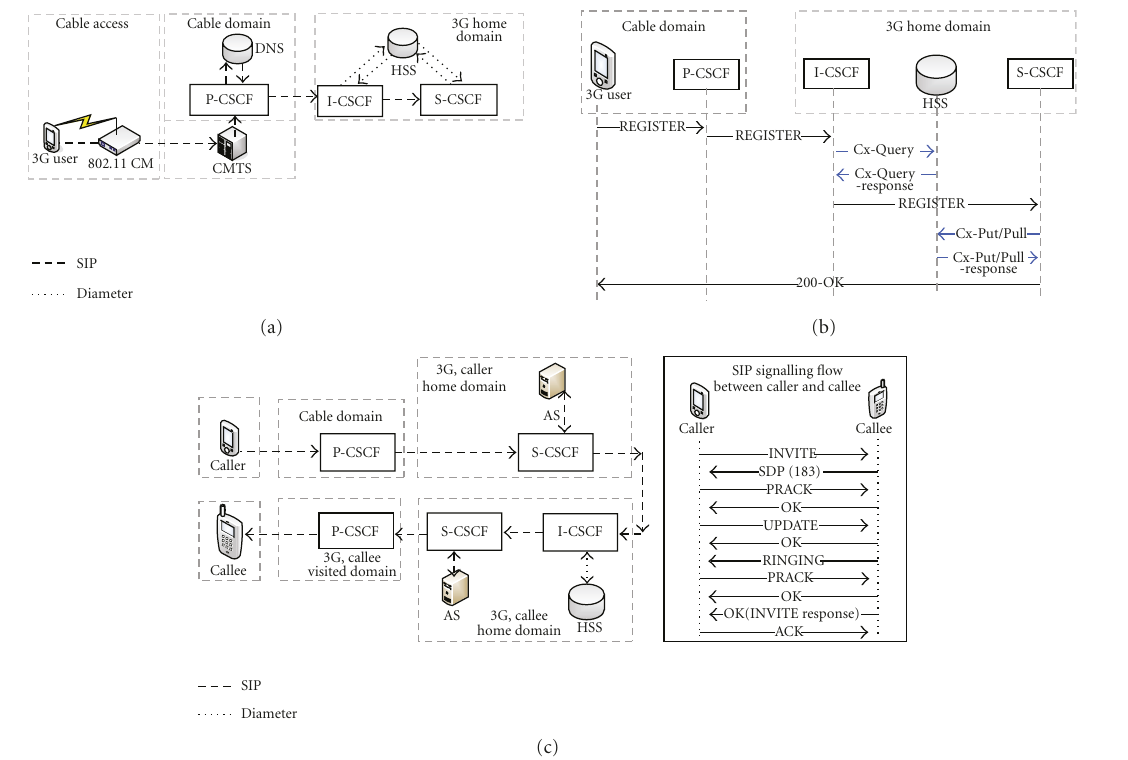
Figure 6: (a) Registration path for a 3G User Roamed in Cable Domain. (b) Registration Signaling Flow for a 3G User Roamed in Cable Domain. (c) Originating Call establishment route/session-flow for a 3G User Roamed in Cable